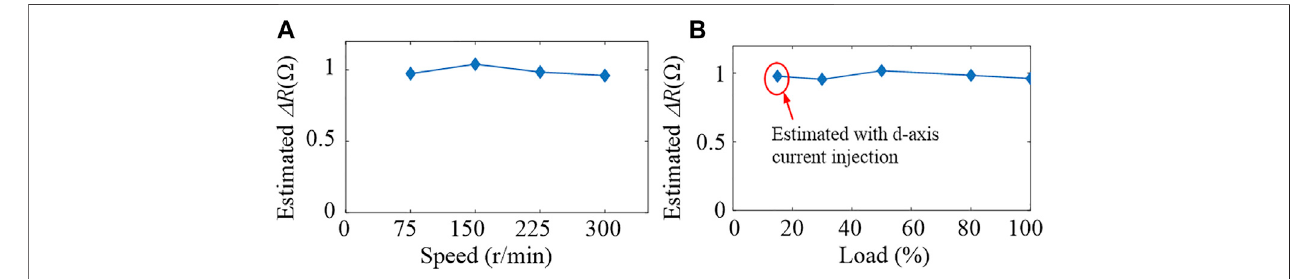
FIGURE 18 | Experimental estimated Δ R . (A) Rated load at different speed; (B) different loads at 300 r/min.